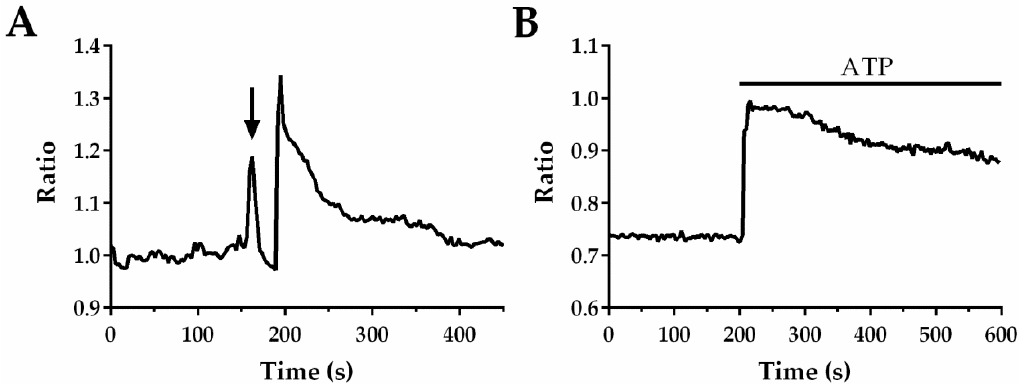
Figure 1. Ca 2+ profiles from in situ endothelial cells obtained under two different stimuli ( A ) Damaging rat aorta inner wall by using the tip of a glass micro-pipette evokes a long-lasting Ca 2+ signal in endothelial cells (ECs) located at the injury site. The arrow indicates the time when injury was performed; ( B ) Intracellular Ca 2+ transient evoked by ATP 300 ( µ M) in in situ ECs from rat aorta. Calcium profile (CPs) were obtained from one single cell using the automated CP extraction method.